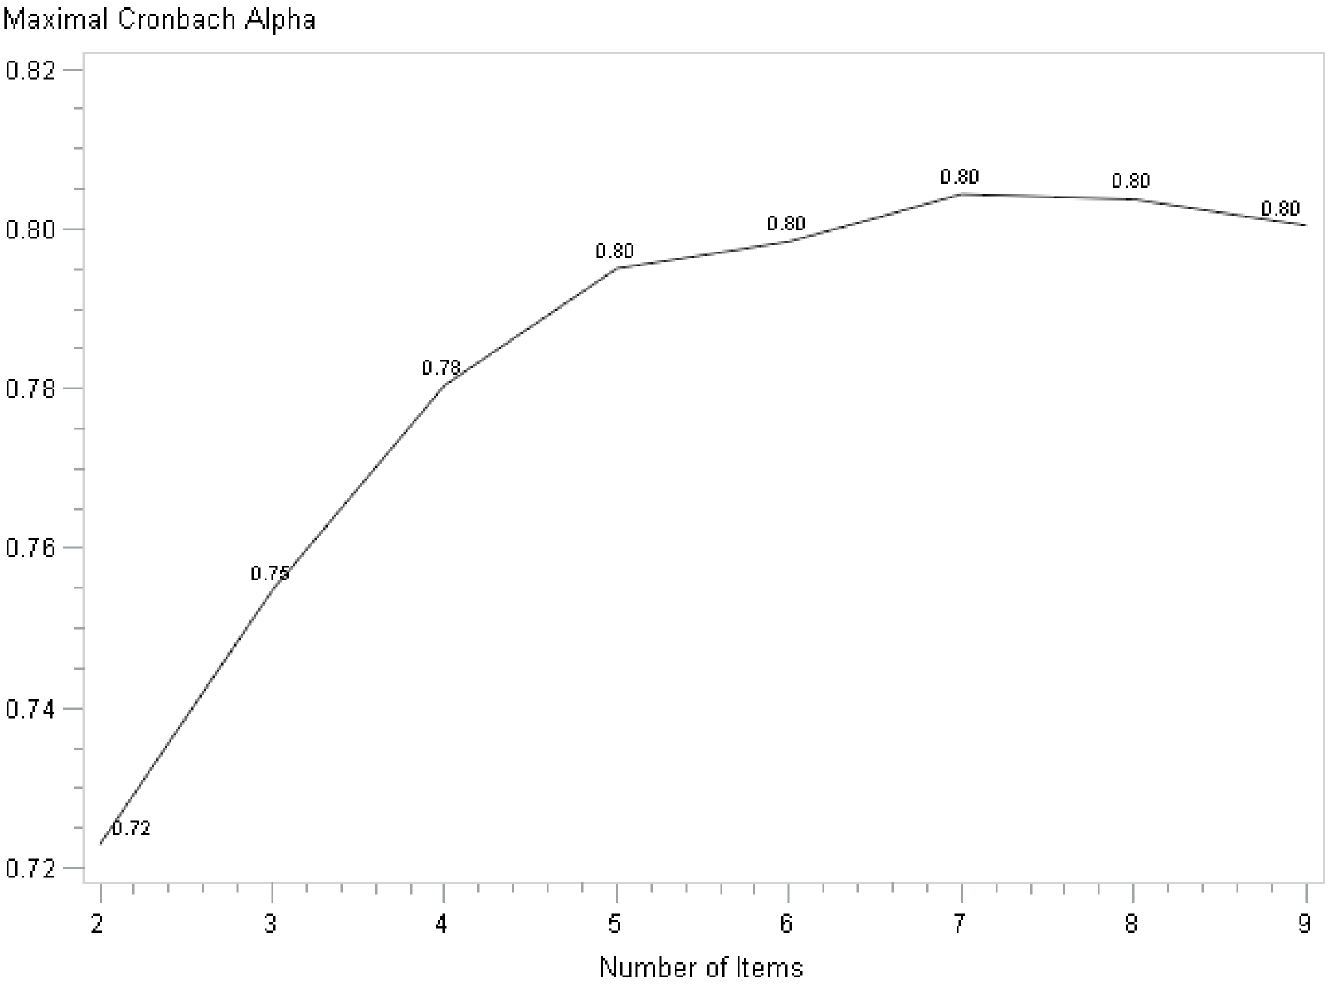
Fig 2. Step-by-step Cronbach α backward procedure according the number of items. The items were successively removedaccordingthe following order: Q8, Q1, Q13, Q12, Q3, Q10, Q2 (remainingQ6 and Q14).